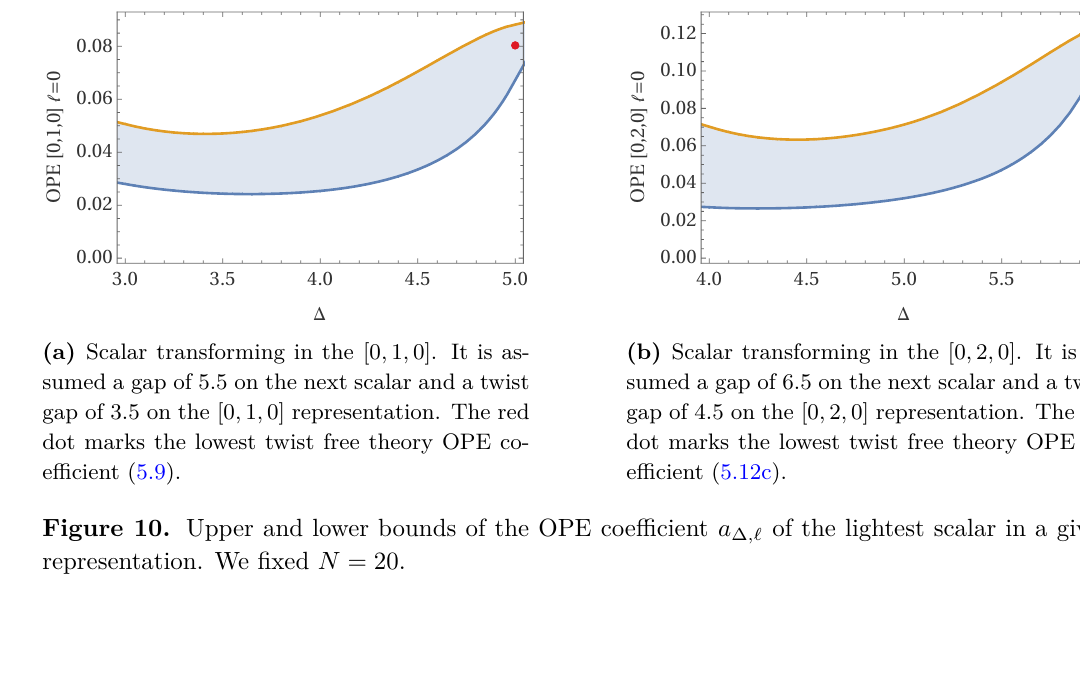
Figure 9. Upper and lower bounds for the OPE coefficient ( λ 2 of the dimension of the scalar singlet ∆ and of the angle θ defined in (6.3). It is assumed a gap on the next scalar singlet of 4 . 2 . For this plot we fixed N = 20 . The angle θ ranges from 0 to 1 . 1 because for higher angles the theory is disallowed. The red dot marks the free theory lowest twist OPE coefficient (5.5) (at t = 2 in the free theory θ = 0 ).